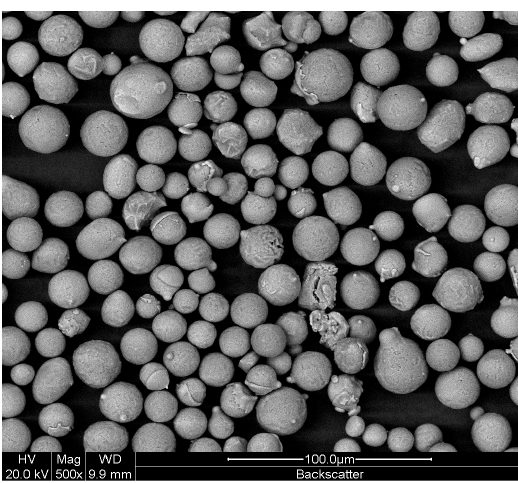
Figure 1. BSE image of WIP-C1 powder.